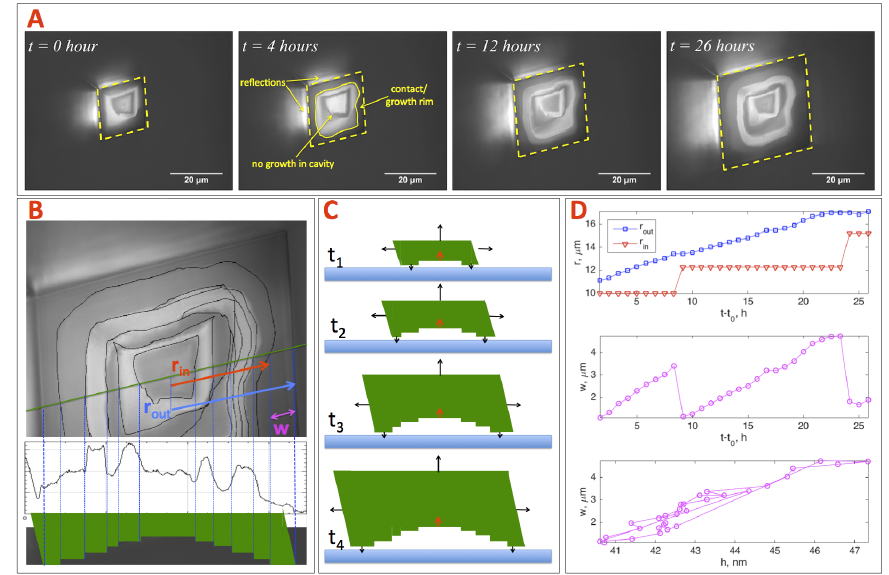
Figure 2. In situ imaging of 26 h of growth of Crystal A, raw data and interpretations: Ω = 0.6, flow direction bottom to top. ( A ) In situ images of the growing 10 ¯1 4 calcite crystal surface confined by glass, imaged from below (see Figure 1). For a full time-lapse movie of the same crystal, see the movie CrystalA.avi. The crystal outline is marked by a dashed line. Dark areas along the rim of the crystal (between the dashed line and whole drawn line in the image at 4 h) signify areas of contact between crystal and glass. The bright, diffuse areas to the left and above the crystal are reflections from the two rhombohedral crystal sides that “overhang” the contact. The time t = 0 is an arbitrary reference time. ( B ) Top: Lines of the inner rim edge position of Crystal A at different times are drawn on the final crystal surface. Middle: Intensity in the image along the green line. Bottom: A sketch of a cut through the crystal along the green line showing the profile of the confined crystal surface. Vertical lines are drawn connecting the image, the intensity plot and the interpreted profile. ( C ) Interpretation of the image sequence in (A). The crystal grows (black arrows) freely on the top and outer surfaces, as well as on the lower surface confined by the glass, causing the crystal to be lifted upwards (red arrow). There is no growth of the crystal in the cavity that forms inside the rim; ( D ) Top: Inner, r in , and outer, r out , radius the of crystal as a function of time. Middle: Rim width, w = r out − r in , versus time. Bottom: Rim width versus distance to glass surface, h